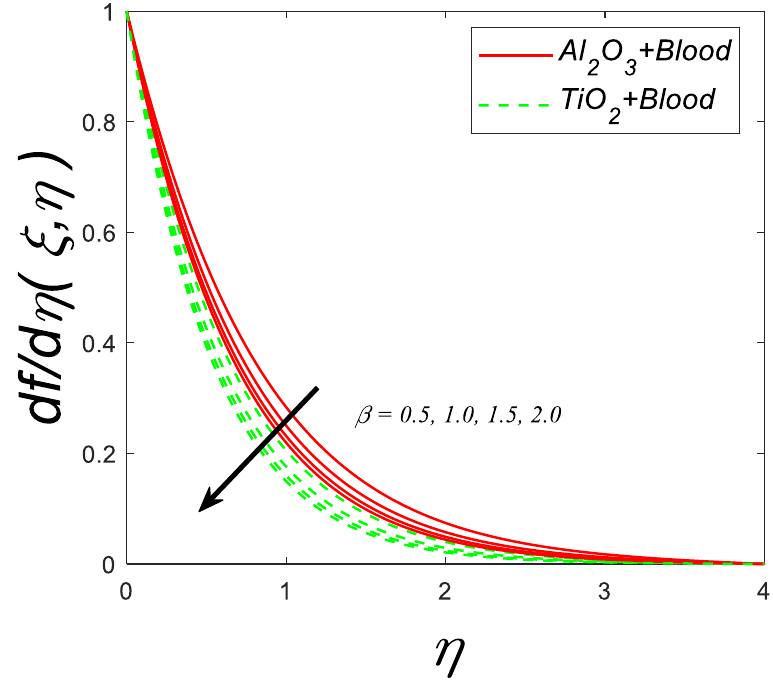
, 𝜉 = 0.1,𝑅𝑑 = , ξ = 0.1, Rd = 0.1, 3 3